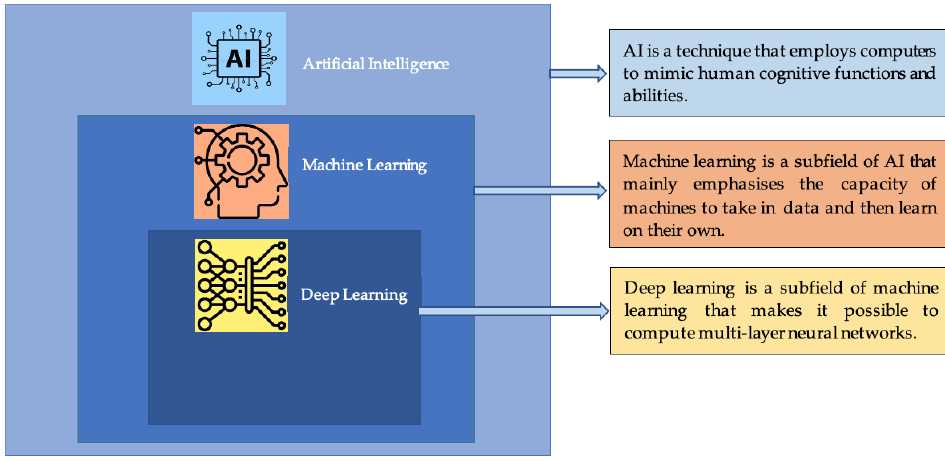
Figure 2. Relationship between AI, machine learning, and deep learning.